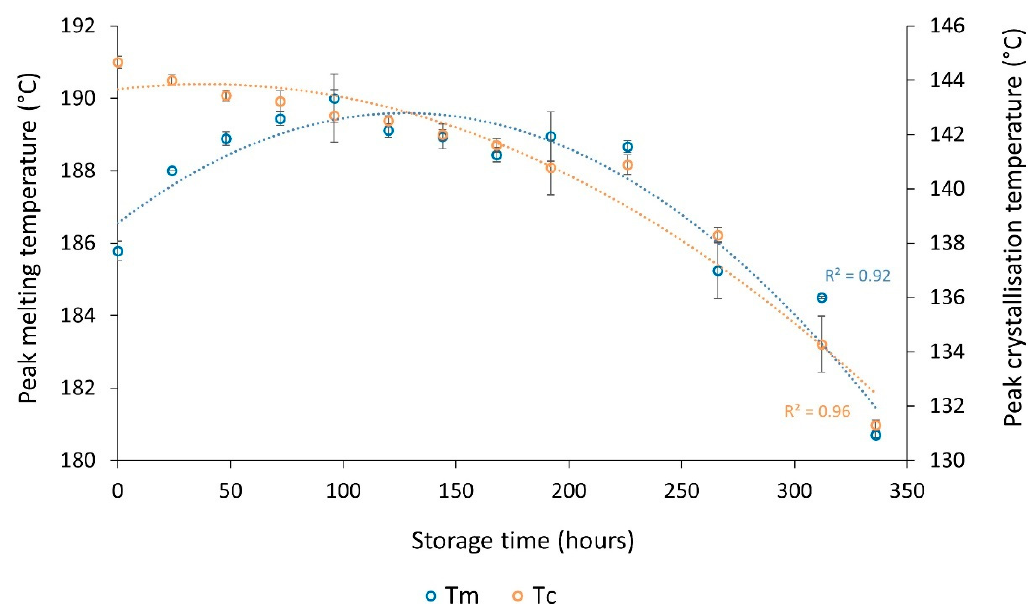
Figure 6. The overall change in T m and T c after storage of PA − 12 at 170 °C for up to 336 h.